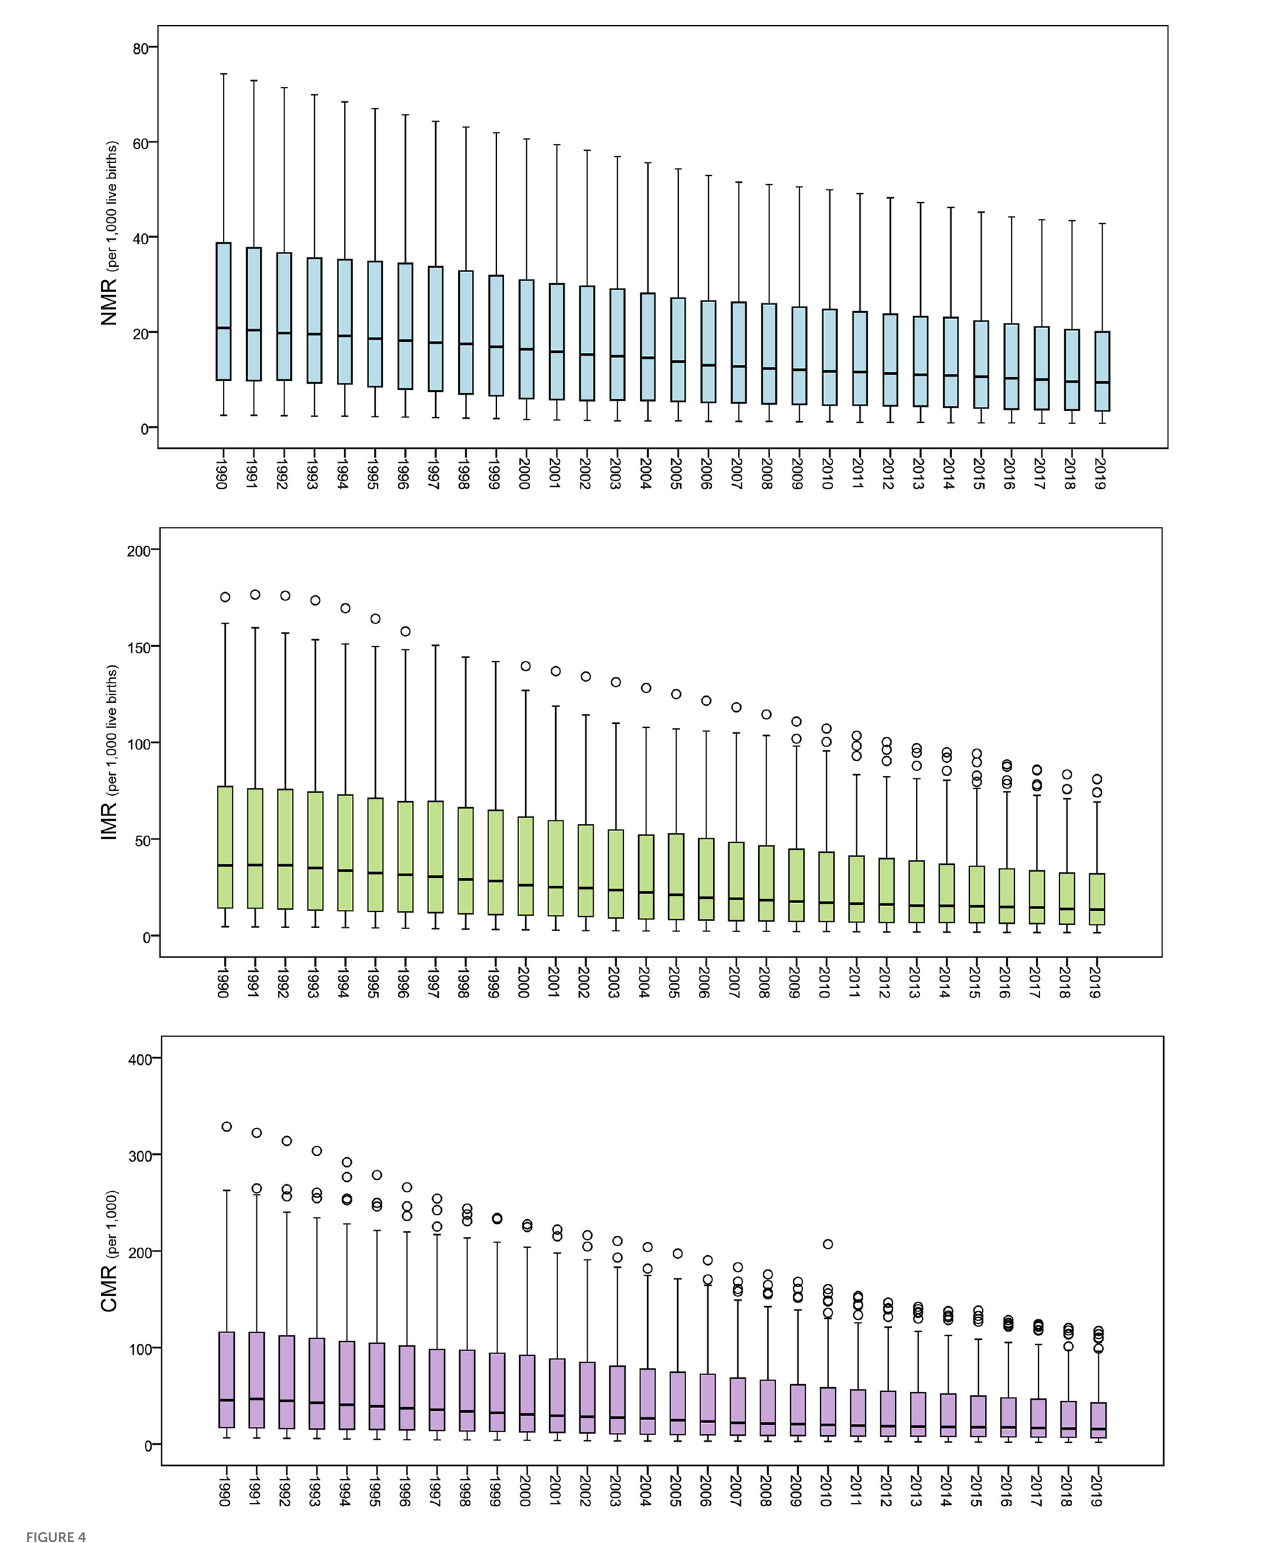
FIGURE4 Boxplot of the global NMR, IMR, and CMR from 1990 to 2019.